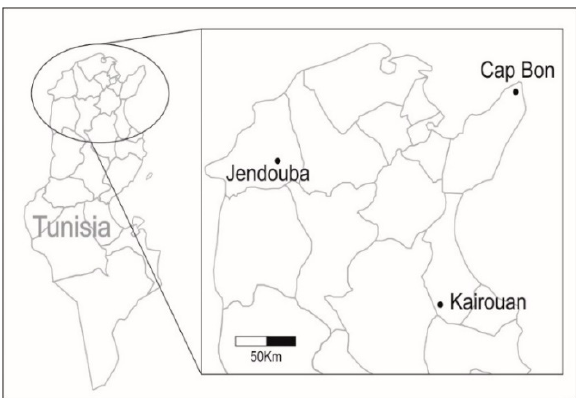
Figure 1. Localities in Tunisia sampled for M. persicae . Peach orchards and potato crops located in Jendouba, Cap Bon and Kairouan were monitored from 2011 to 2016.